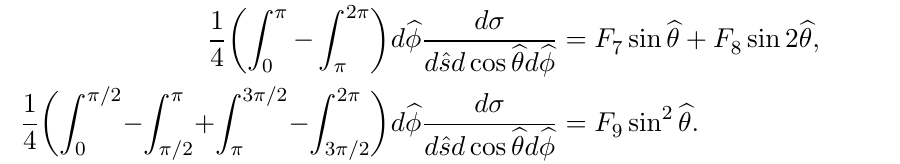
Figure 6 . The coe(cid:14)cients F the same manner as (cid:12)gure 5. These coe(cid:14)cients are constrained to be identically zero by CP e T invariance. In each panel, 2 points give predictions for h Z h (cid:13) = 0 + 0 : 1 i . 3